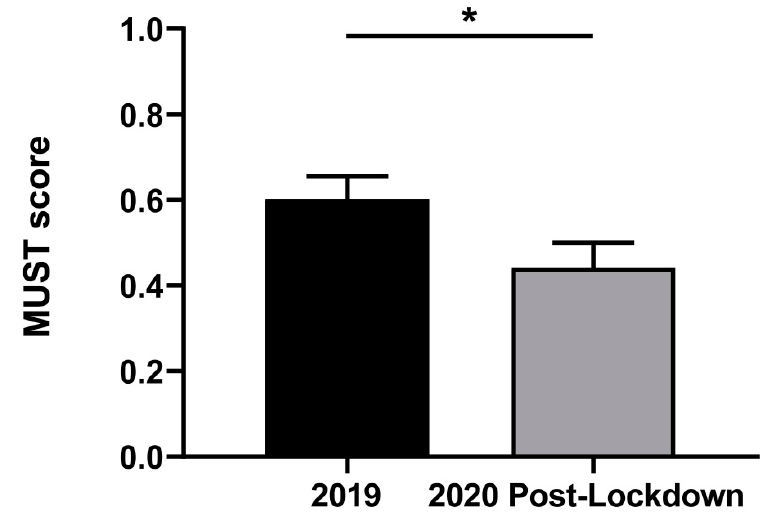
Figure 2. Comparison of nutritional screening score measured with the Malnutrition Universal Screening Tool (MUST) of patients with cancer admitted in 2019 and after the lockdown in 2020. Differences were assessed by two-tailed unpaired Student-s t -test; * p < 0.05.